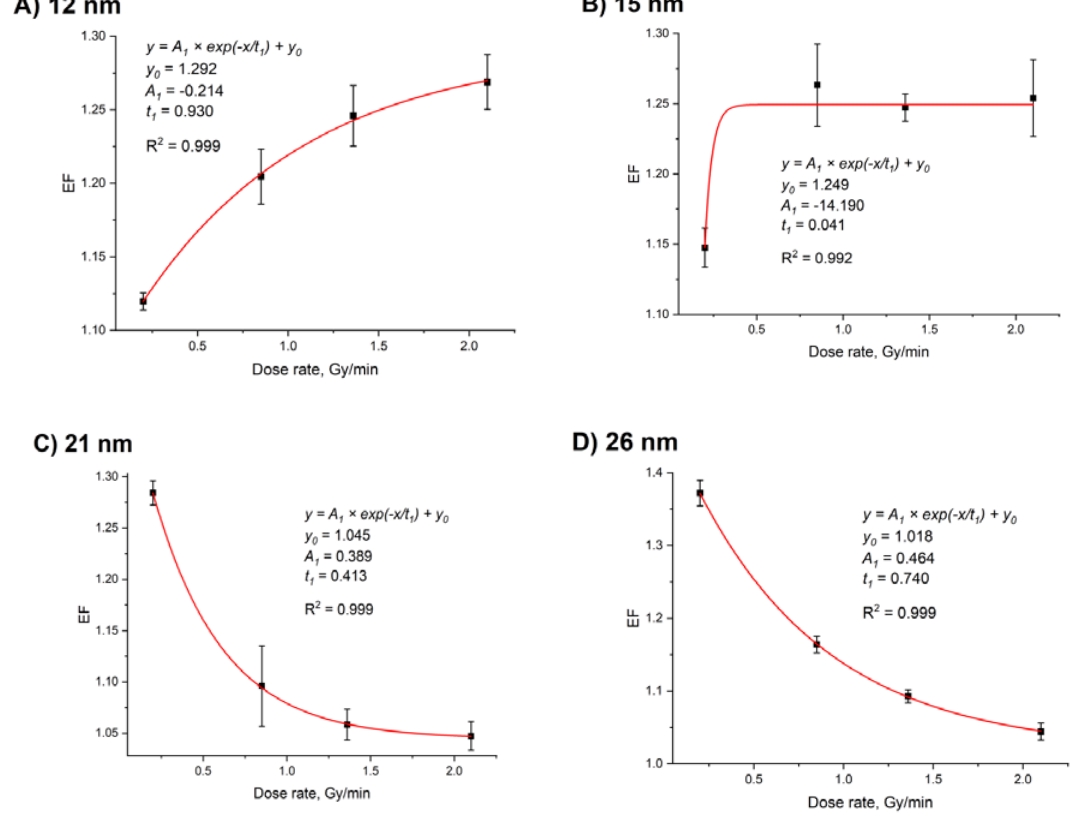
Figure 9. EF as a function of the dose rate for GNPs with a size of 12 nm ( A ), 15 nm ( B ), 21 nm ( C ), 26 nm ( D ) at a fixed dose (5 Gy) and tube voltage (200 kVp). Fitting was performed according to the exponential model. The GNP:DNA ratios in the samples were 15.3 (12 nm), 7.8 (15 nm), 2.8 (21 nm), and 1.5 (26 nm) particles per one DNA molecule. Error bars are mean confidence intervals calculated by three parallel independent measurements for α =